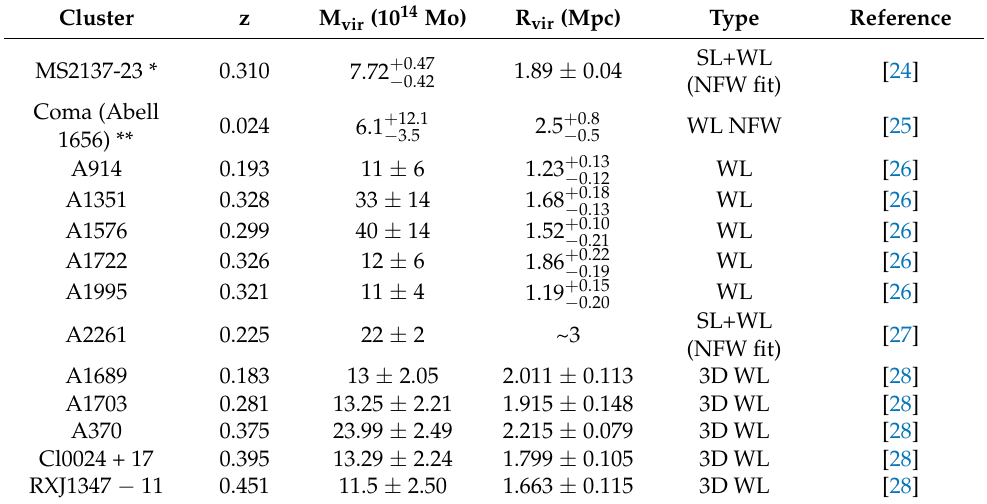
Table 4. Identified weak lensing data and two data points from weak lensing and strong lensing data which used an NFW density fit.